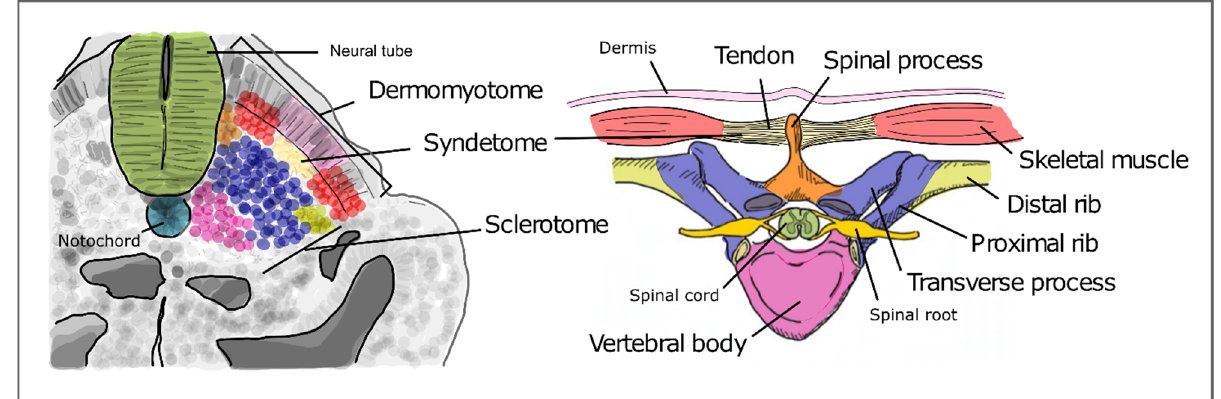
Figure 5. Differentiation of the different somite regions into definitive axial structures. After budding off from the PSM as epithelial spheres, somite differentiation takes place distinguishing the prospective cell populations that will give rise to adult structures. Colors in the figure represent precursor cells in the somite ( left ) and their respective definitive structures ( right ).